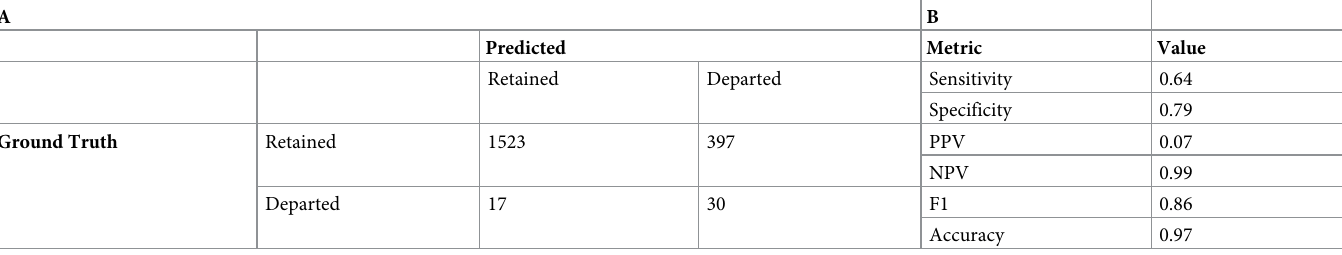
Table 2. Model performance at optimal threshold using Youden’s J index. A 2x2 confusion matrix for the optimal threshold showing physician-month counts and B classification performance statistics. PPV is Positive Predictive Value; NPV is Negative Predictive Value. F1 is the harmonic mean of PPV and Sensitivity.